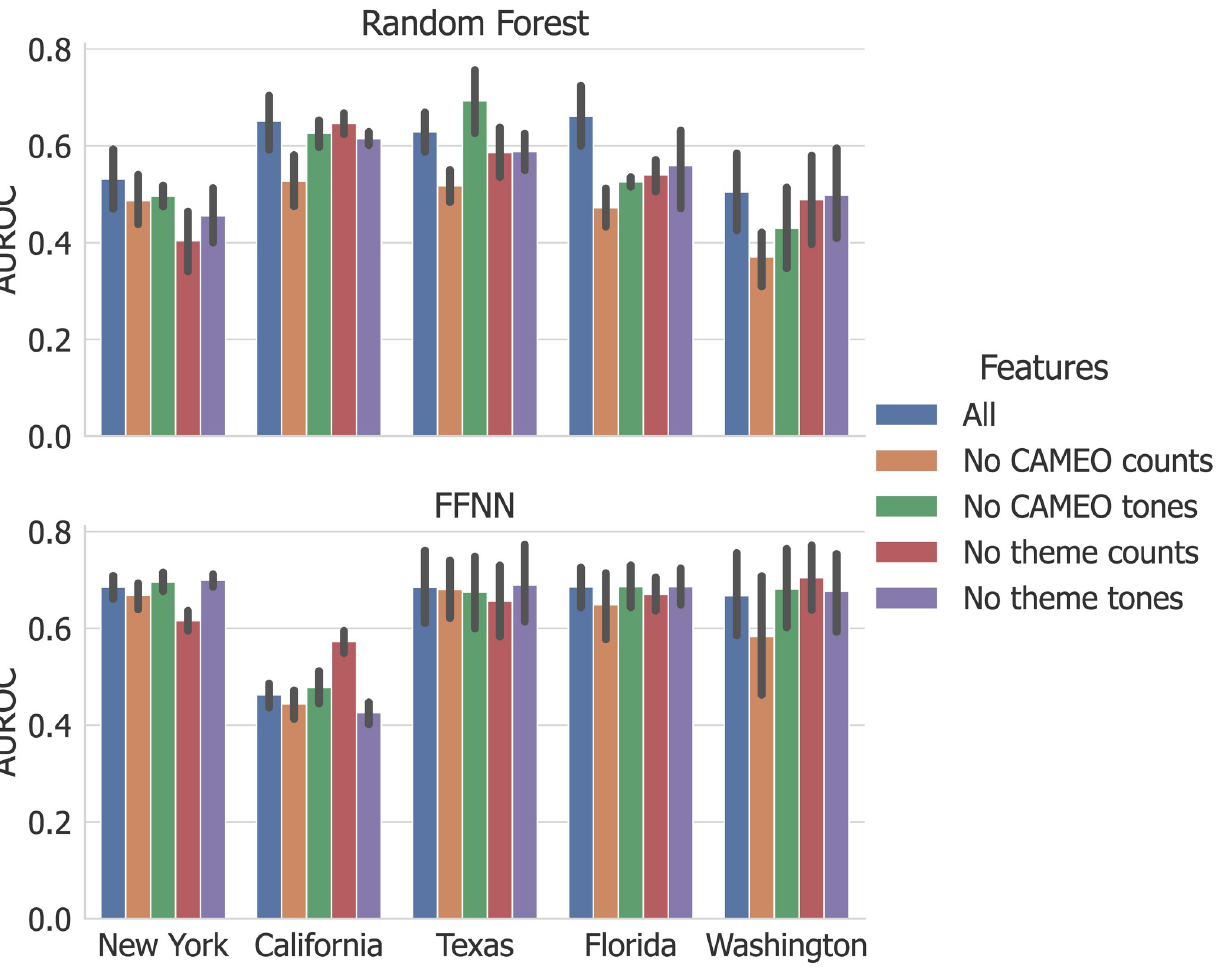
Fig 6. Classification results for models trained on subsets of features. For both RF (top) and FFNN (bottom), each state was evaluated using the baseline model along with four additional models, each of which was trained without one of the major feature groups. Error bars represent standard deviations between folds in each 5-fold cross-validation